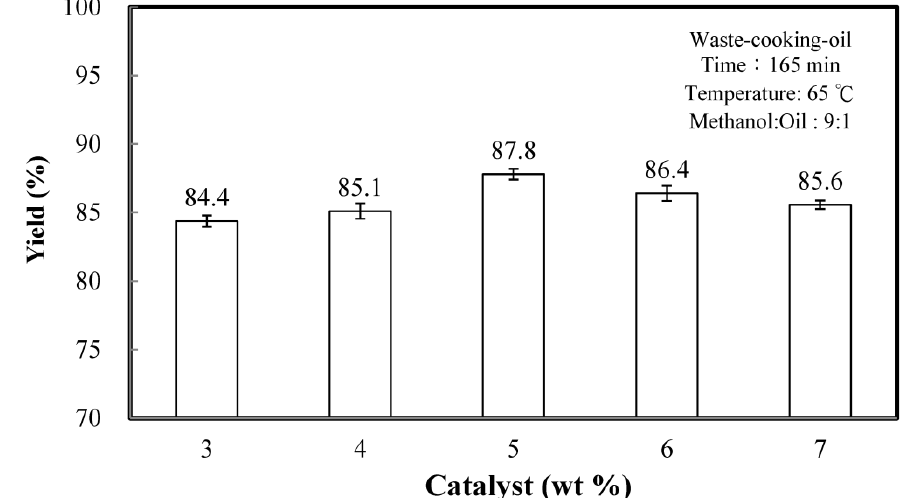
Figure 4. Effects of catalyst on the harvest (production) of biodiesel under a microwave system.